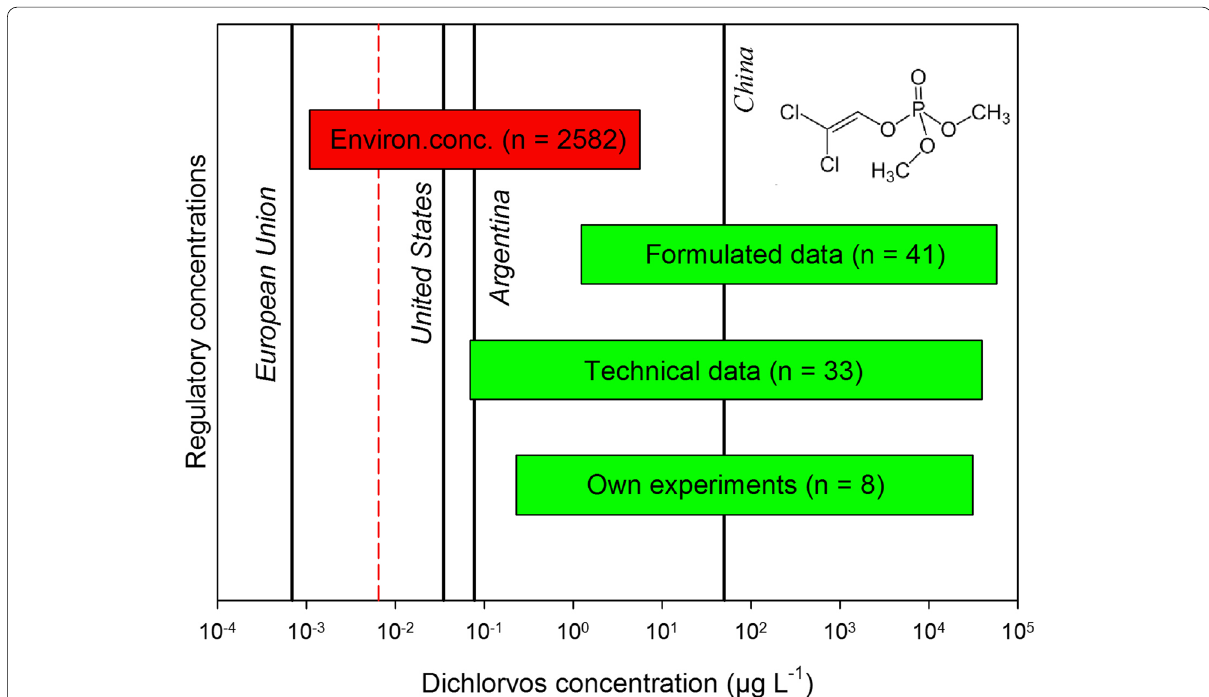
Fig. 3 Regulatory concentrations from different regions (vertical lines), proposed EQC from this study (red broke thicker line), monitored environmental concentrations range (red bar), and range of EC 50 values (green